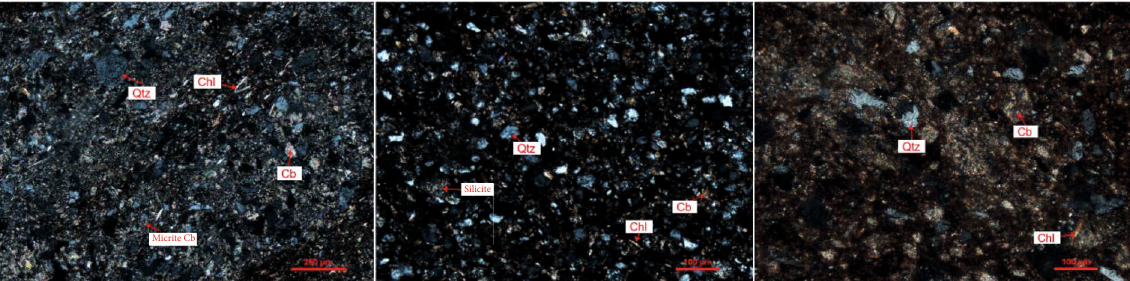
Figure 9: Thin-section mesostructure of Yunnan red-bed mudstone in three